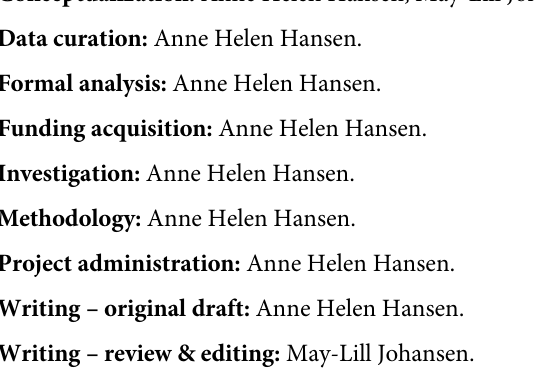
S1 Table. Probability of outpatient specialist visits adjusted for response time. S2 Table. Probability of outpatient specialist visits for patients with two or more GP visits during the previous